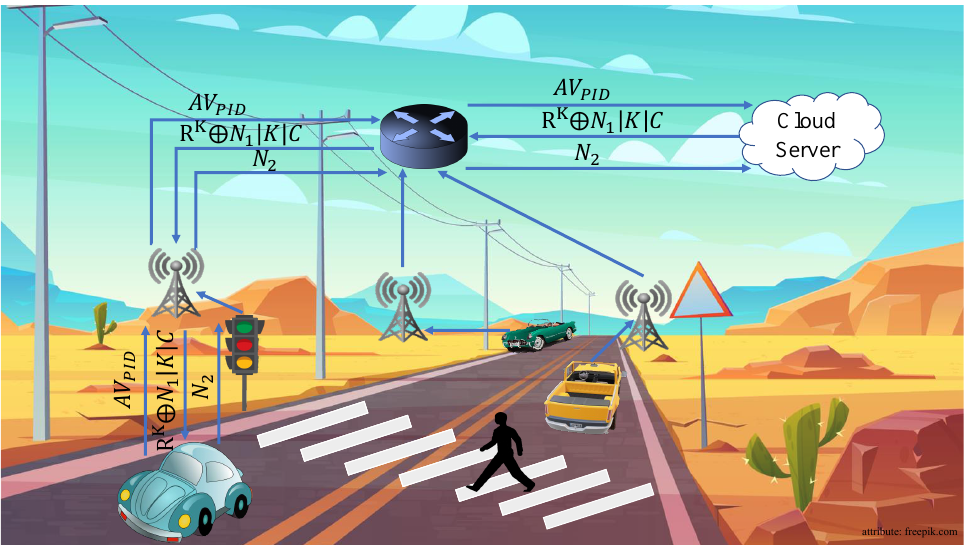
Figure 6. Schematic view of the proposed authentication framework.